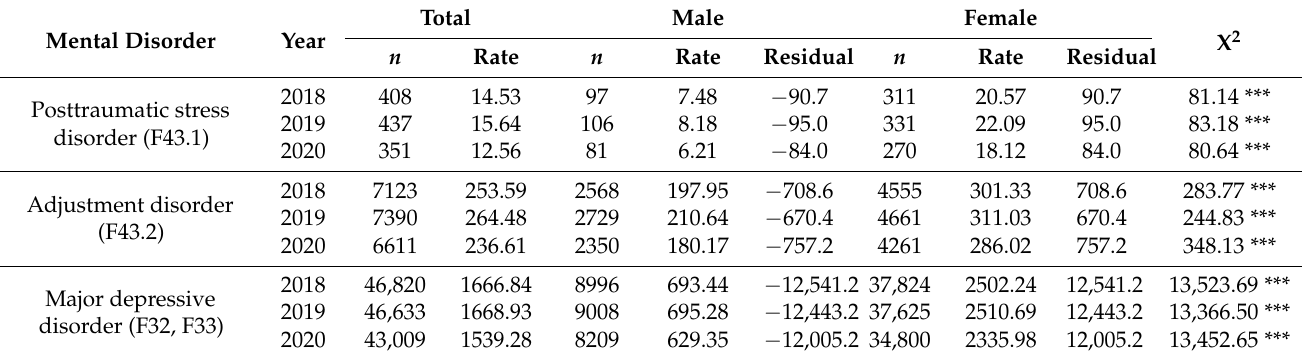
Table 1. Cases of stress-related disorders and depression in Lithuanian national healthcare in 2018–2020. Mental